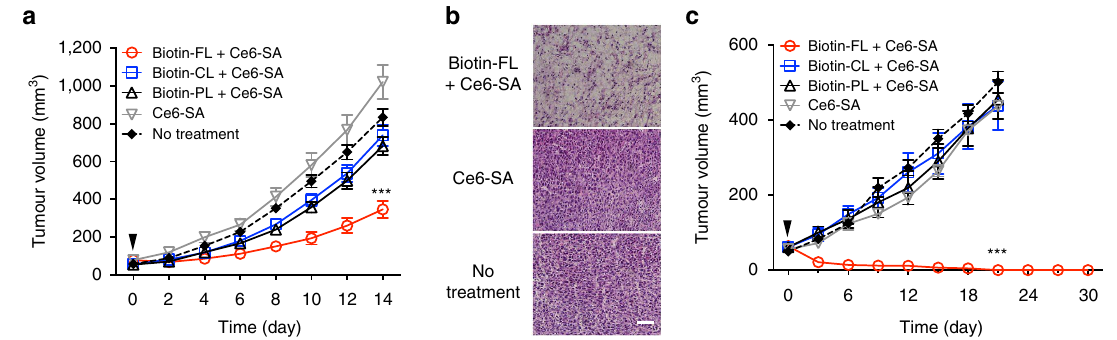
Figure 6 | Cooperative tumour cell membrane-targeted phototherapy. ( a ) Tumour growth inhibition by cooperative membrane-targeted phototherapy in 4T1 tumours. ( b ) Histological observation of 4T1 tumours visualized using haematoxylin and eosin staining at day 2 after cooperative membrane-targeted phototherapy. Scale bar represents 100 m m. ( c ) Tumour growth inhibition by cooperative membrane-targeted phototherapy in MDA-MB-231 tumours. Arrowheads indicate laser irradiation after two-step targeted delivery. Data are mean ± s.e.m. ( n ¼ 6 in each group, *** P o 0.001 for treatment compared with the other groups using one-way analysis of variance (ANOVA) with Tukey’s post hoc